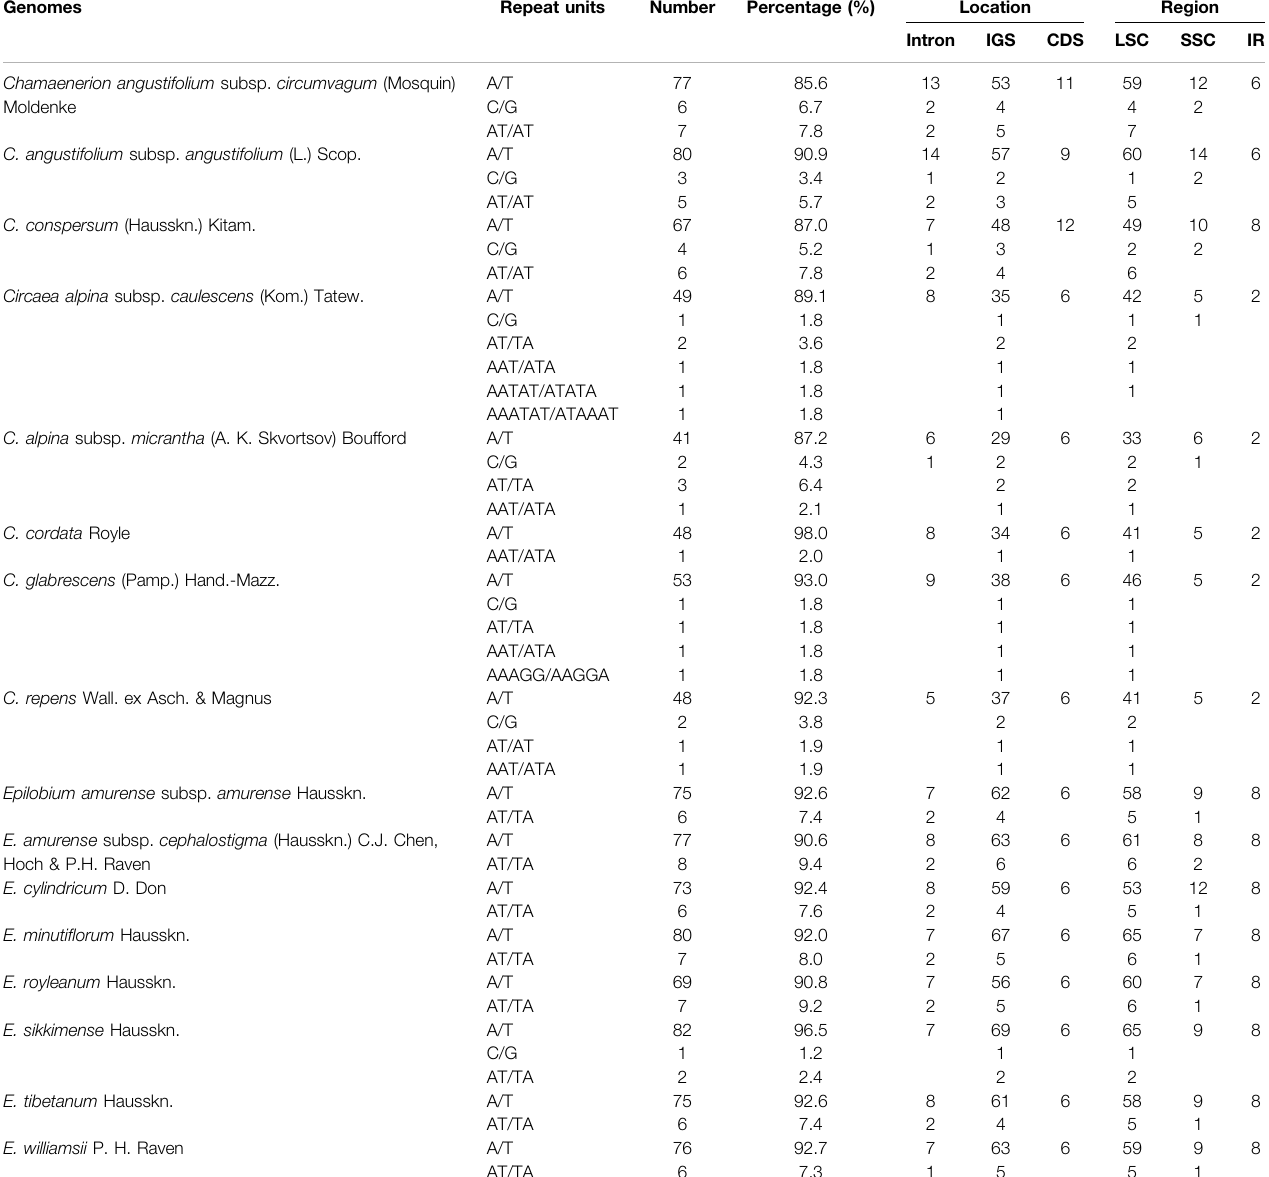
TABLE 2 | Simple sequence repeats (SSRs) for the 16 newly sequenced Epilobium , Circaea , and Chamaenerion samples. Genomes Repeat